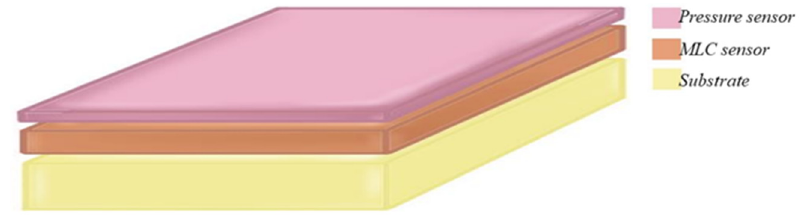
Figure 1. General cross-sectional layer structure of a multimodal DE.